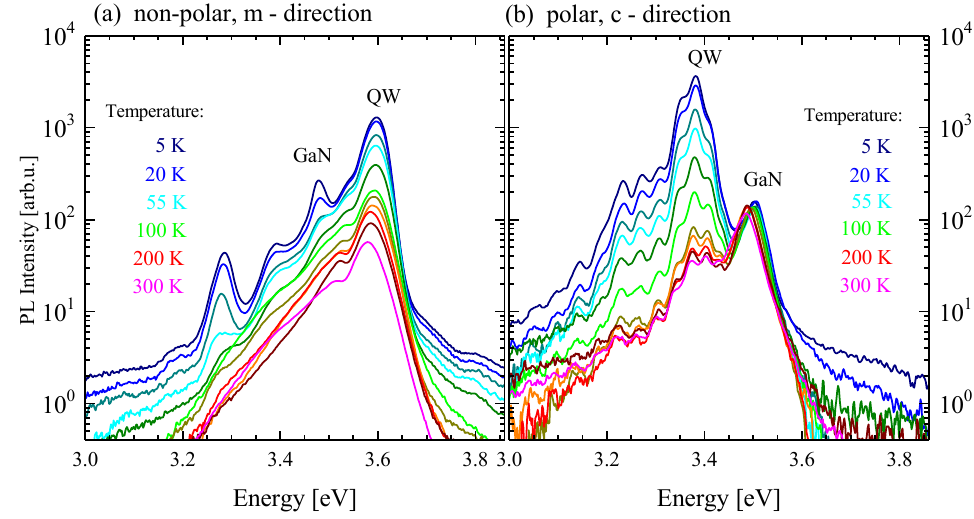
Figure 5. The temperature dependence of PL spectra of ( a ) non-polar and ( b ) polar GaN/Al 0.26 Ga 0.74 N (3 nm/22.5 nm) MQW structures. The oscillations visible in Panel ( b ) are due to reflection at the GaN/Si interface and the resulting Fabry–Pérot interferences.